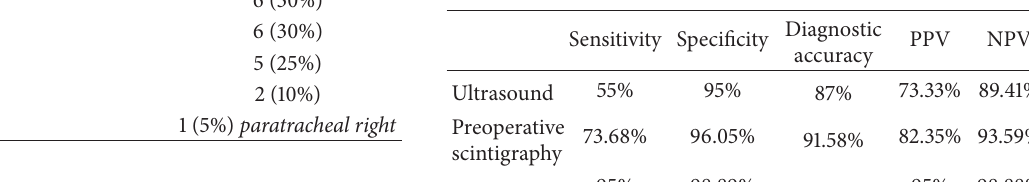
Table 5: Sensitivity, specificity, diagnostic accuracy, PPV, and NPV of the localisation used according to the quadrant of the